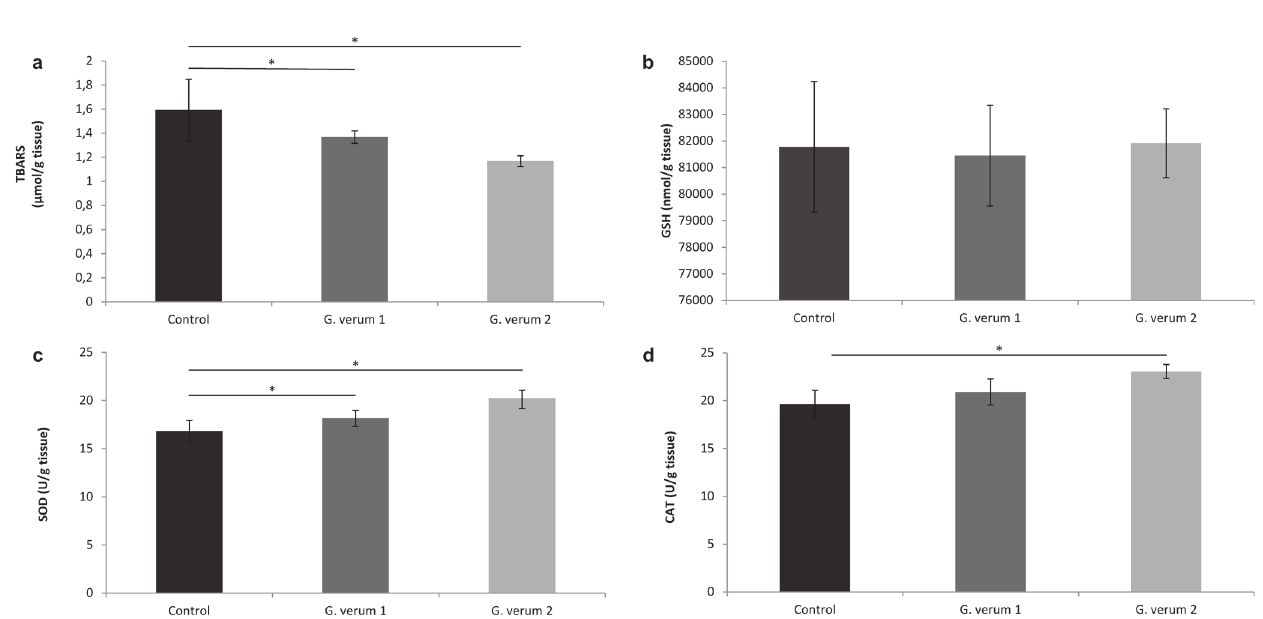
FIGURE 1 - Parameters of oxidative stress and antioxidant defence system in heart tissue in healthy, G. verum 1 and G. verum 2 treated rats. (a) TBARS value comparison between groups, (b) SOD value comparison between groups, (c) CAT value comparison between groups, (d) GSH value comparison between